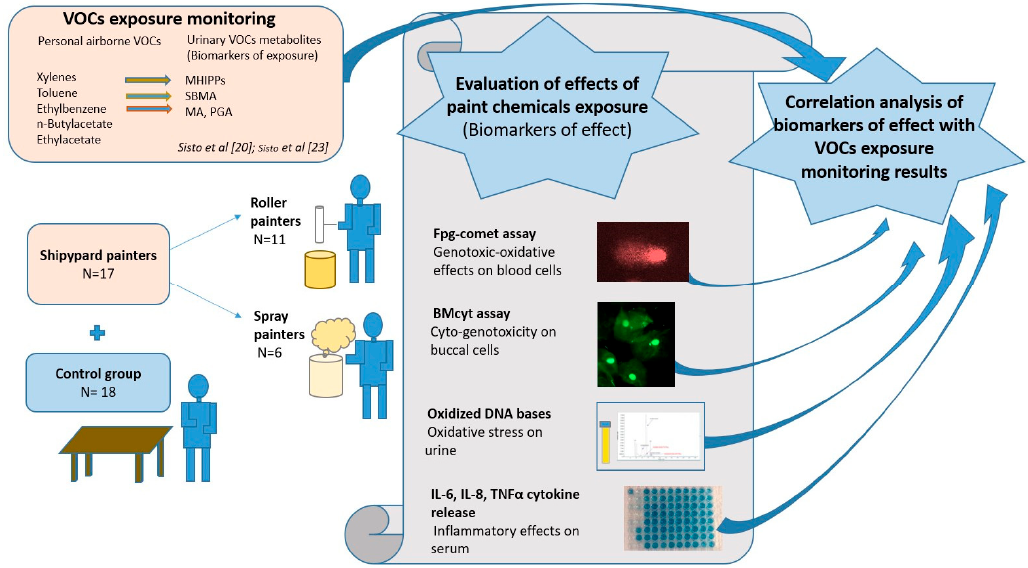
Figure 1. Study design.